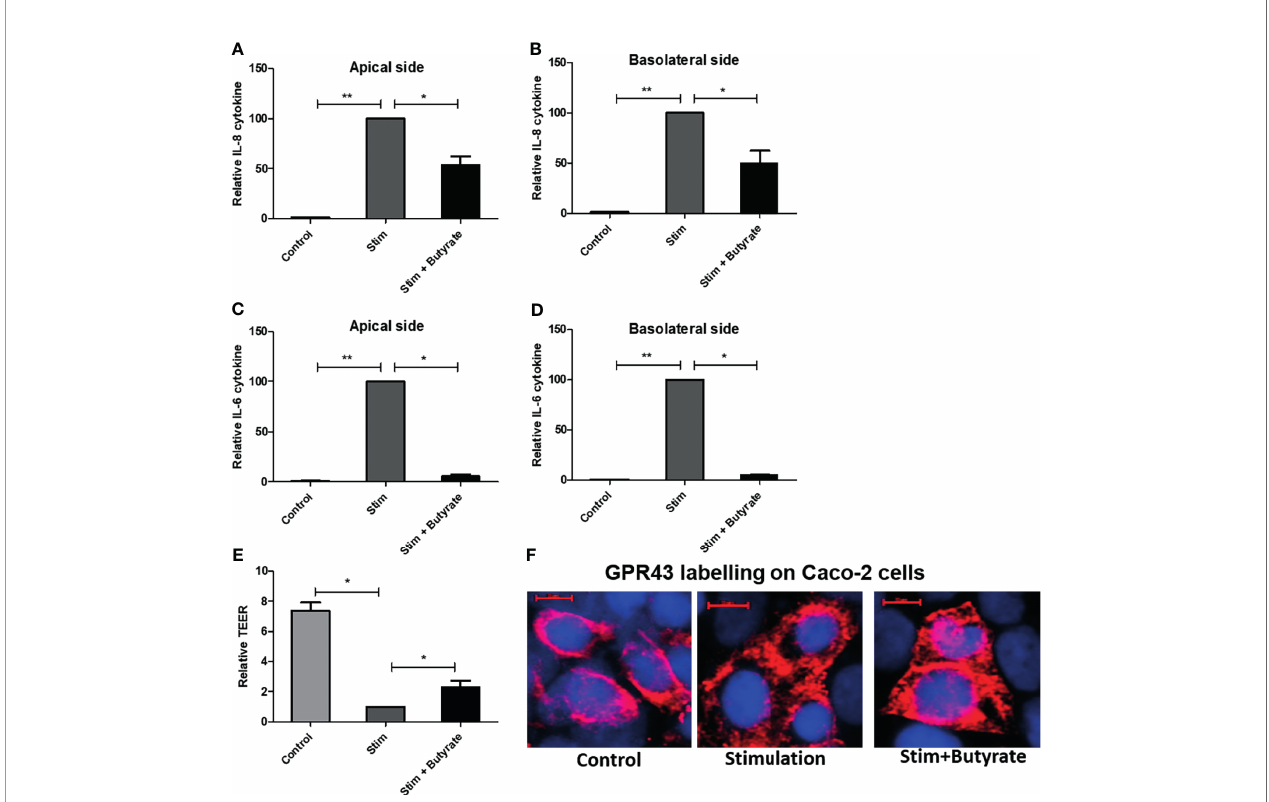
FIGURE 7 | Effect of butyrate on human epithelial cell. Caco-2 cell were grown on collagen coated transwell for 21 days. Cell were treated with IL-1 b and TNF for 24 hours without or with butyrate. (A, B) IL-8 cytokine release on apical and basolateral side of Caco-2 cells. (C, D) IL-6 cytokine release on apical and basolateral side of Caco-2 cells. (E) . Transepithelial electrical resistance (TEER) changes with stimulation (stim) alone or with butyrate. (F) GPR43 staining of Caco-2 cells in untreated control, stimulated control and butyrate treated condition. GPR43 is labelled with AF 594. Nucleus is counterstained with DAPI. Scale bar: 10µm. n = 4 independent experiments. Bar represents mean +/- s.e.m. *p < 0.05, **p < 0.01, Mann-Whitney U